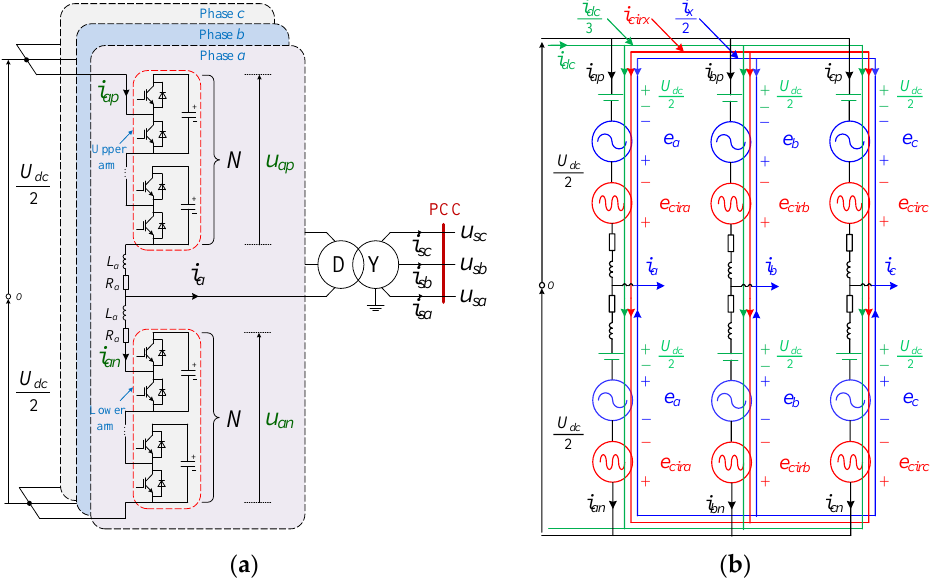
Figure 1. Block diagram of the MMC: ( a ) circuit topology; ( b ) equivalent circuit.